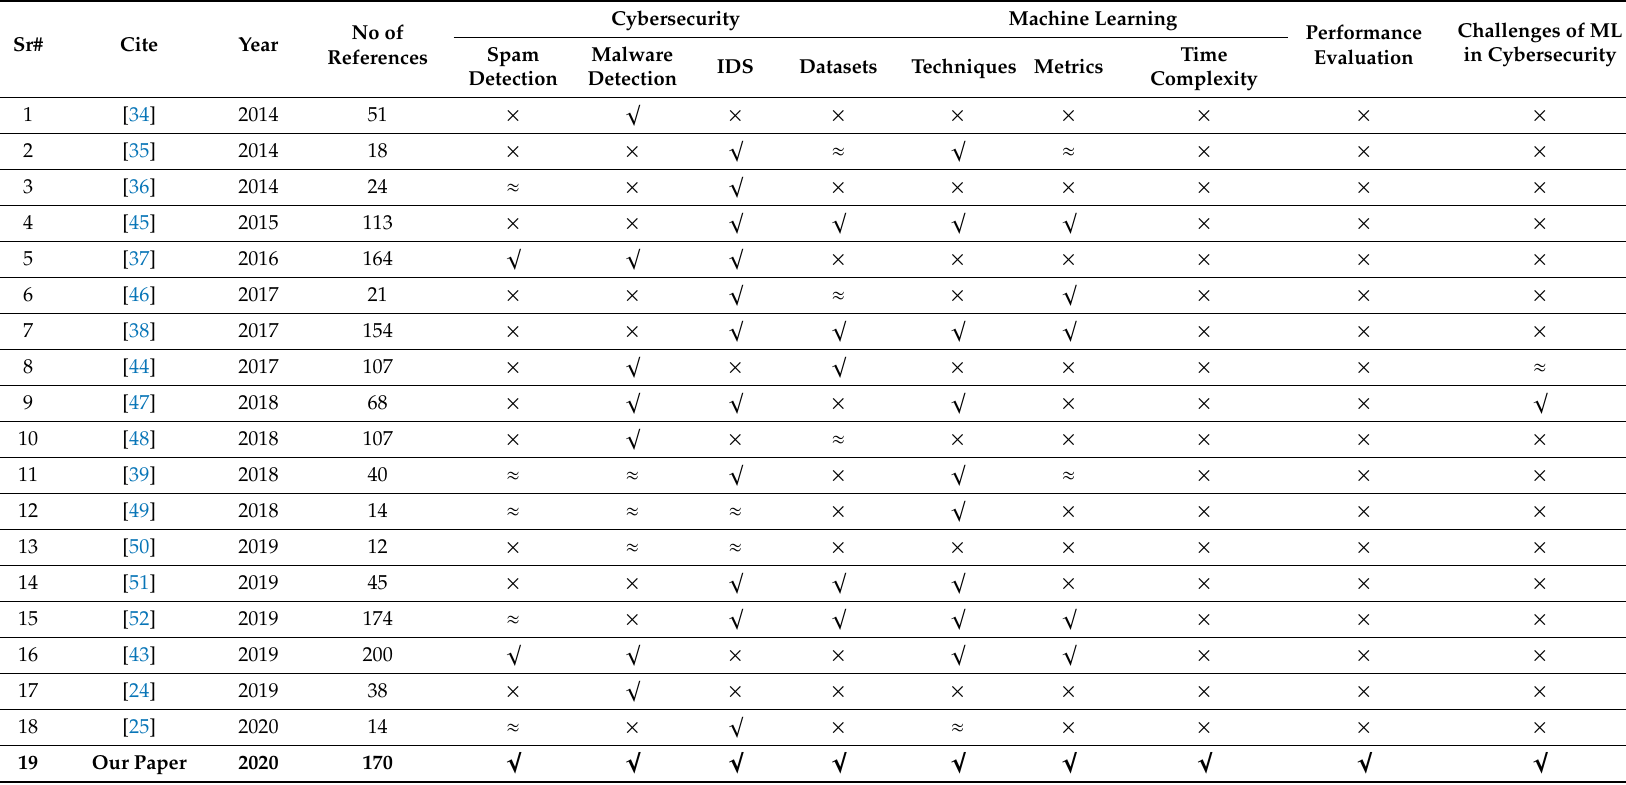
√ means covered; ≈ means partially covered; × means not